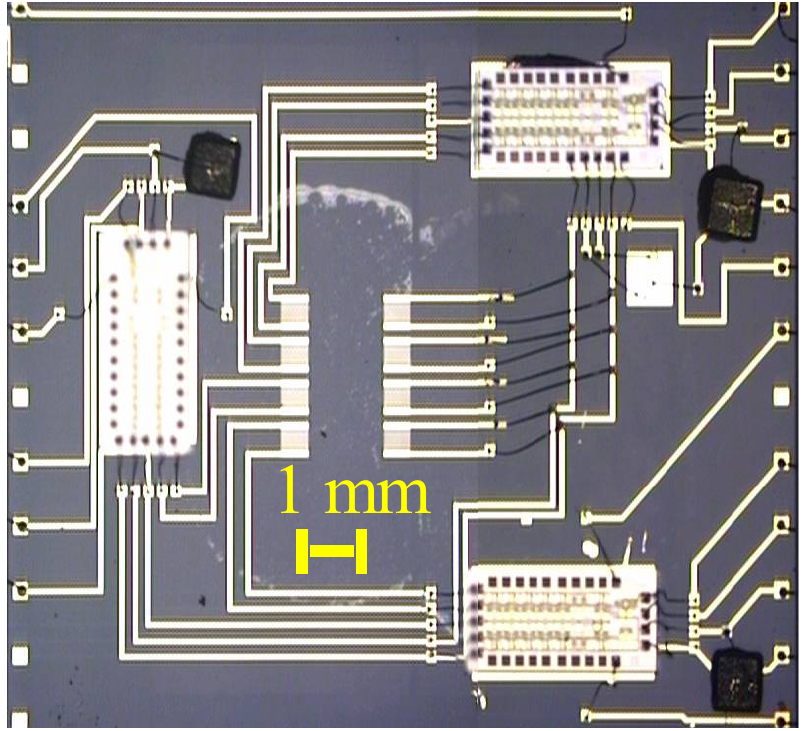
Figure 4. Four SAW sensor elements aligned vertically on an application specific integrated circuit. One delay line is left uncoated to compare frequency shifts of the other polymer or sol-gel coated